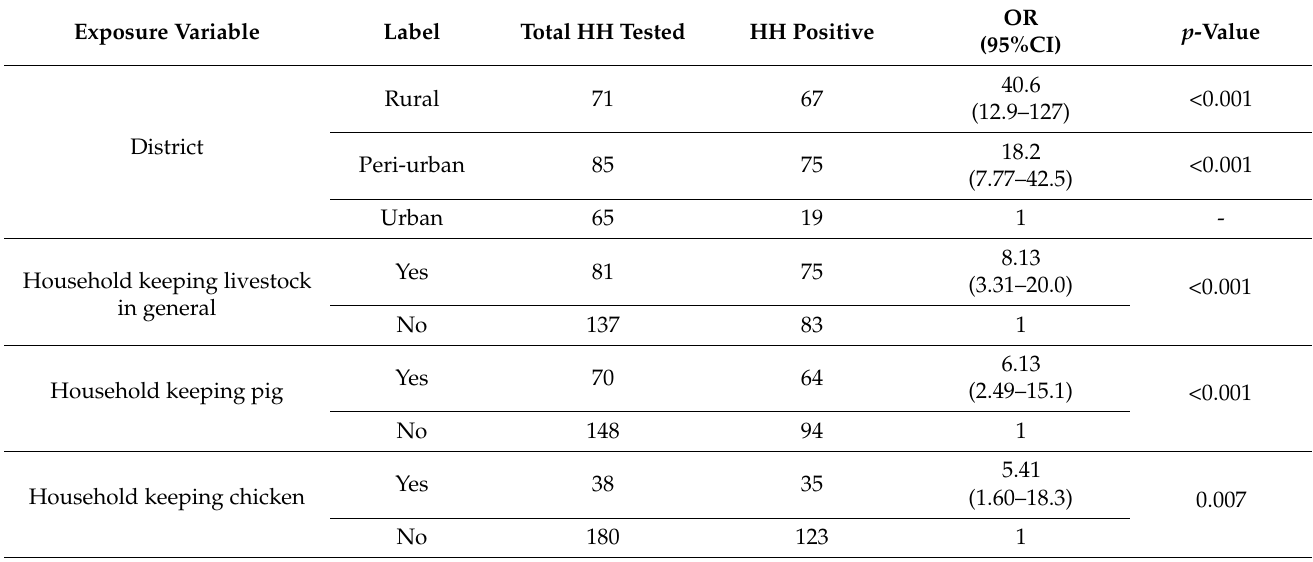
Table 3. Results from univariable analysis showing the association between seropositivity of households and exposure